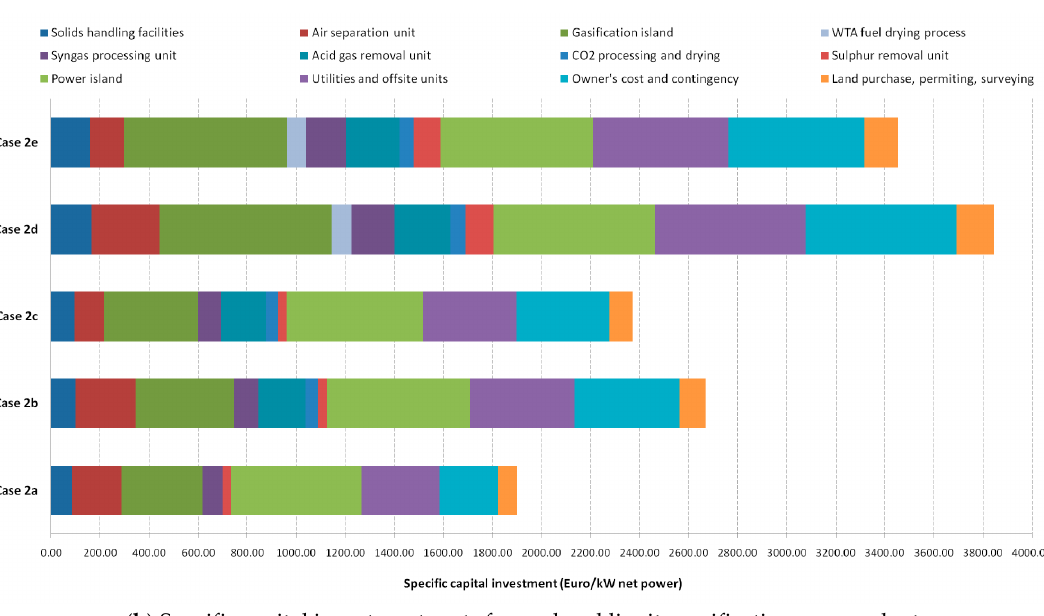
Figure 5. Specific capital investment costs for oxy-combustion and gasification power plants.